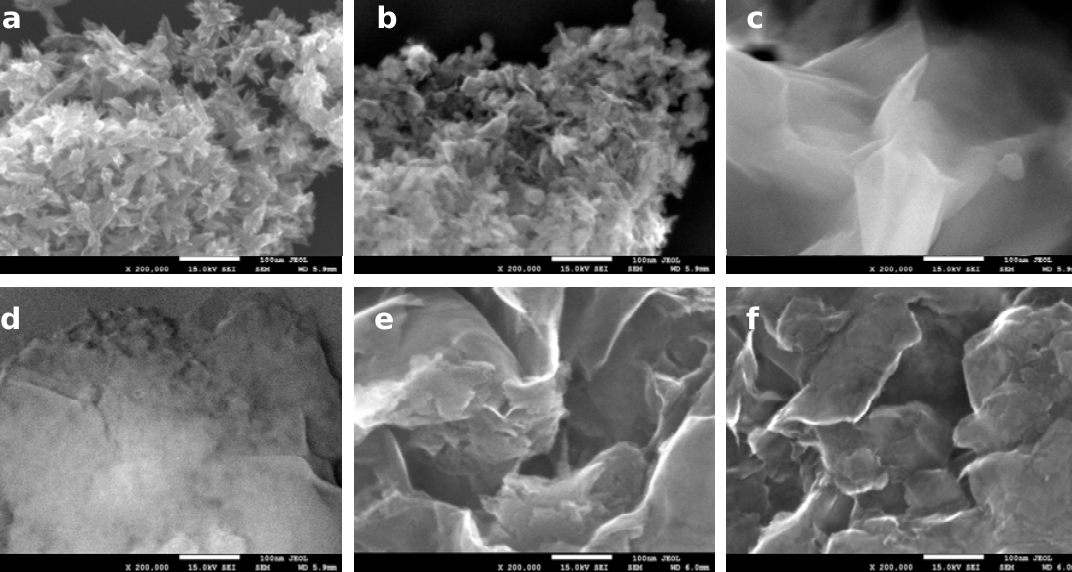
Figure 4. High resolution (HR) SEM images of ( a ) precipitate obtained from neutralized micellar TiO 2 precursor; ( b ) as received MnAl(im); ( c ) CTA ‐ Mt exfoliated in 1 ‐ hexanol; ( d ) micellar TiO 2 precursor; ( b ) as received MnAl(im); ( c ) CTA-Mt exfoliated in 1-hexanol; MnAl(im)/Ti ‐ IMEC NaOH ‐ II ‐ 600; ( e ) MnAl(im)/Ti ‐ IMEC NH3 ‐ II ‐ 600; ( f ) MnAl(im)/CTA ‐ Mt ‐ 600. ( d ) MnAl(im)/Ti-IMEC NaOH -II-600; ( e ) MnAl(im)/Ti-IMEC NH3 -II-600; ( f )